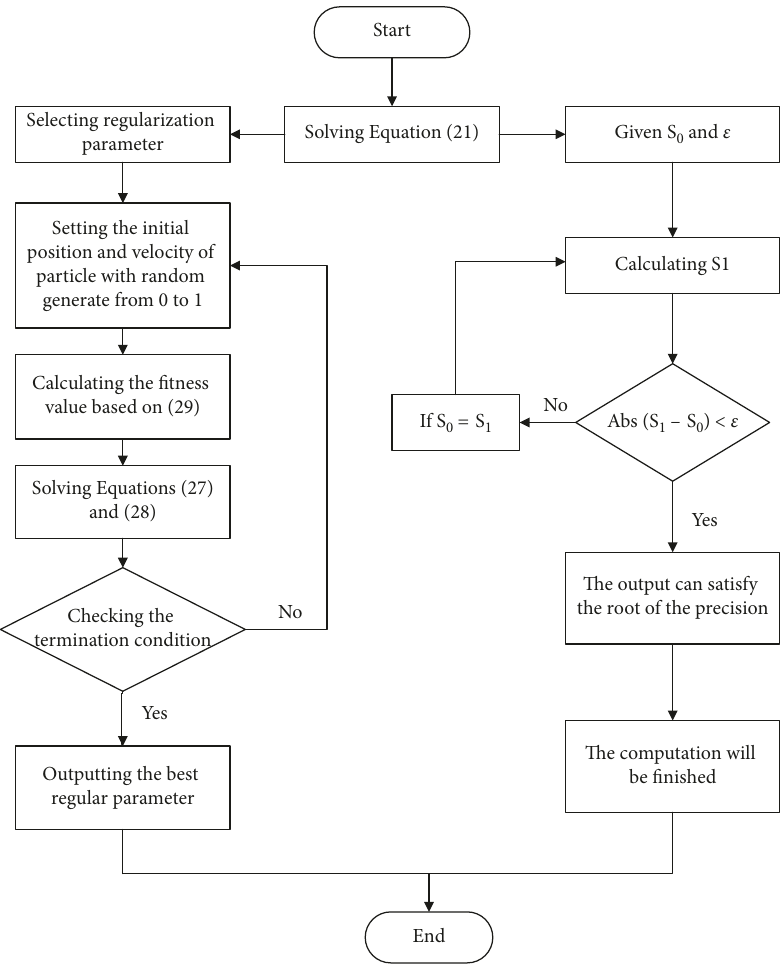
Figure 2: The flow chart of the whole computational algorithm. Table 1: Material parameters of experimental coal seam and rock seam.